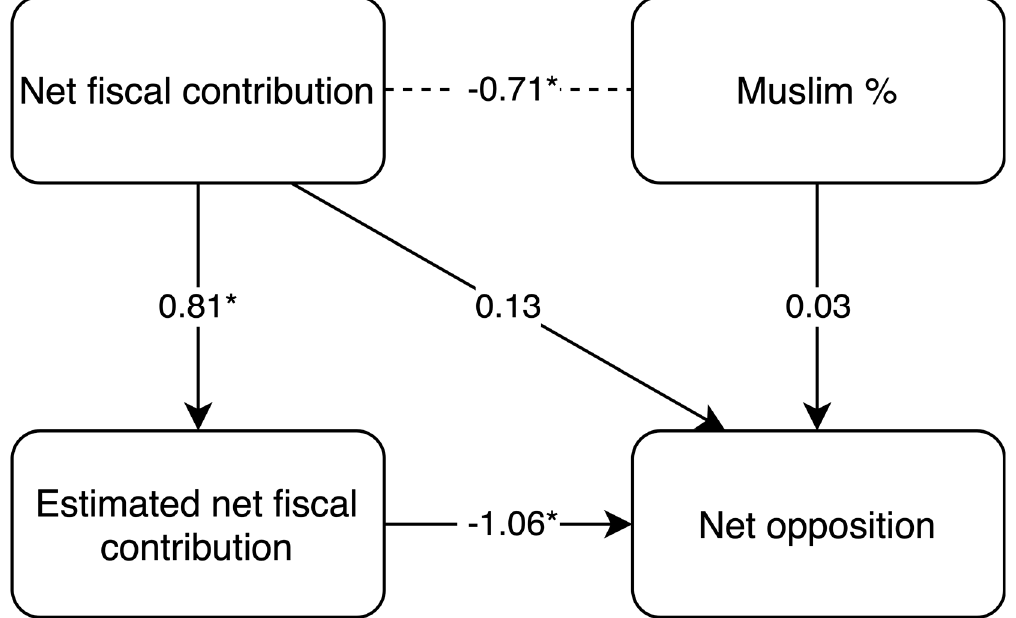
Figure 3. Path model for aggregate preferences. Values are standardized regression coe ffi cients. Asterisks denote significance at p > 0.05 (Syria